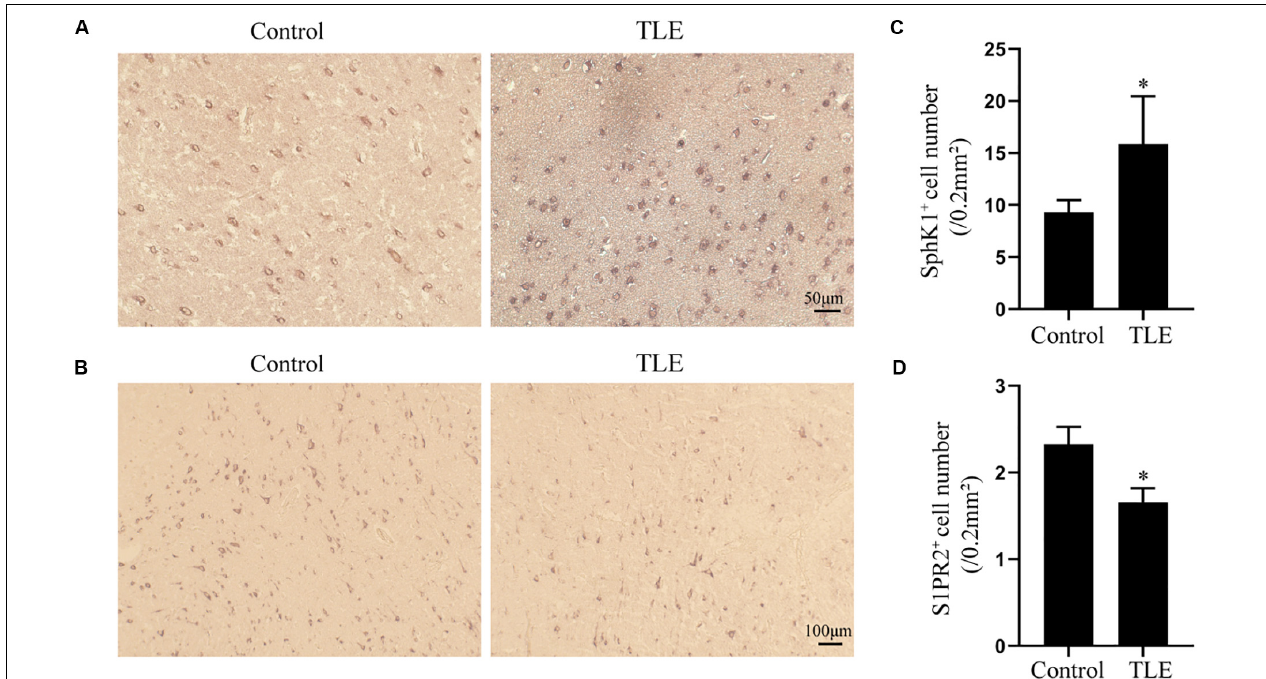
FIGURE 7 | Immunohistochemical analysis of SphK1 and S1PR2 expression in drug-resistant TLE patient temporal cortex. (A) Representative SphK1 immunostaining in the temporal cortex specimens of control patients and drug-resistant TLE patients. (B) Representative S1PR2 immunostaining in the temporal cortex specimens of control patients and drug-resistant TLE patients. (C) Quantitative analysis of the number of SphK1-positive cells in the temporal cortex. (D) Quantitative analysis of the number of S1PR2-positive cells in the temporal cortex. Data are presented as mean ± SD, Student’s t -test, ∗ P < 0.05 versus the control